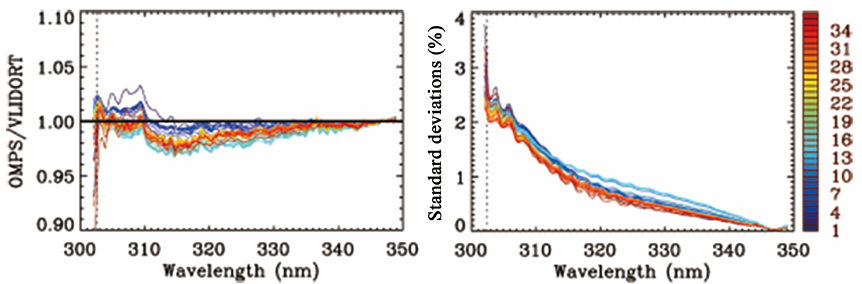
Figure 6. (a) Soft calibration spectrum derived from OMPS-measured to simulated radiance ratio at initial iteration, as a function of wave- length ranging from 302 to 350nm. The vertical dotted line indicates 302.5nm. OMPS data used in this calculation are limited to tropical clear-sky conditions (latitude < ± 15 ◦ , cloud fraction <0.1, surface reflectivity <0.1) for 25 days between 1 and 25 March 2013. Forward model inputs listed in Table 1 are used for OMPS simulations. (b) Standard deviations of fitting residuals. Different colors represent various cross-track positions.